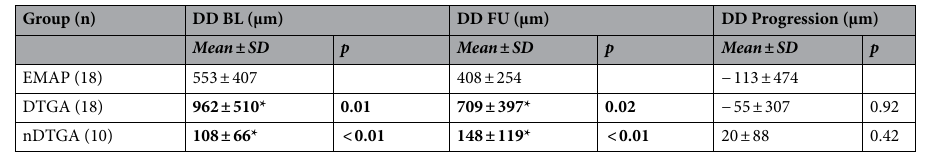
Table 4. Ellipsoid Zone Disruption Distance from the atrophic area. Data expressed as mean ± standard deviation. BL Baseline; FU Follow-up; DD Disruption distance; n number of patients; SD standard deviation; EMAP Extensive macular atrophy with pseudodrusen-like appearance; DTGA Diffuse-trickling geographic atrophy; nDTGA non-diffuse-trickling geographic atrophy. * p < .001 for the comparison with EMAP group using Tukey HSD post-hoc test for ANOVA. Significant values are in